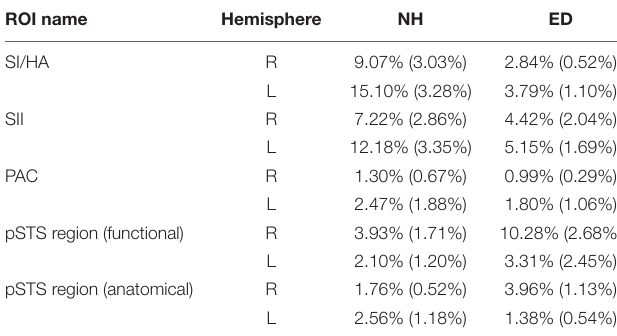
TABLE 4 | Percentage of voxels that demonstrated significant directional tuning within ROIs anatomically defined (SI/HA, SII, PAC, and pSTS) and functionally defined pSTS